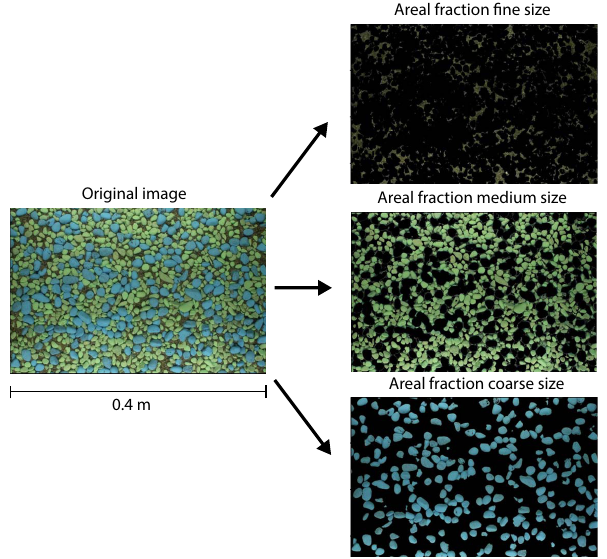
Figure 4. Floating part of the equipment for measuring the grain size distribution of the bed surface during the laboratory experi- ments. Here the bottom and the walls of the floating part are made of thin Plexiglas ® plates and higher Plexiglas ® sheets are attached along the walls to avoid water overflow. The numbers indicate (1) position of the camera, (2a) upper pipe, (2b) lower pipe, (3) car- riage, (4) LED light attached to the cooling plate, and (5) floating part.